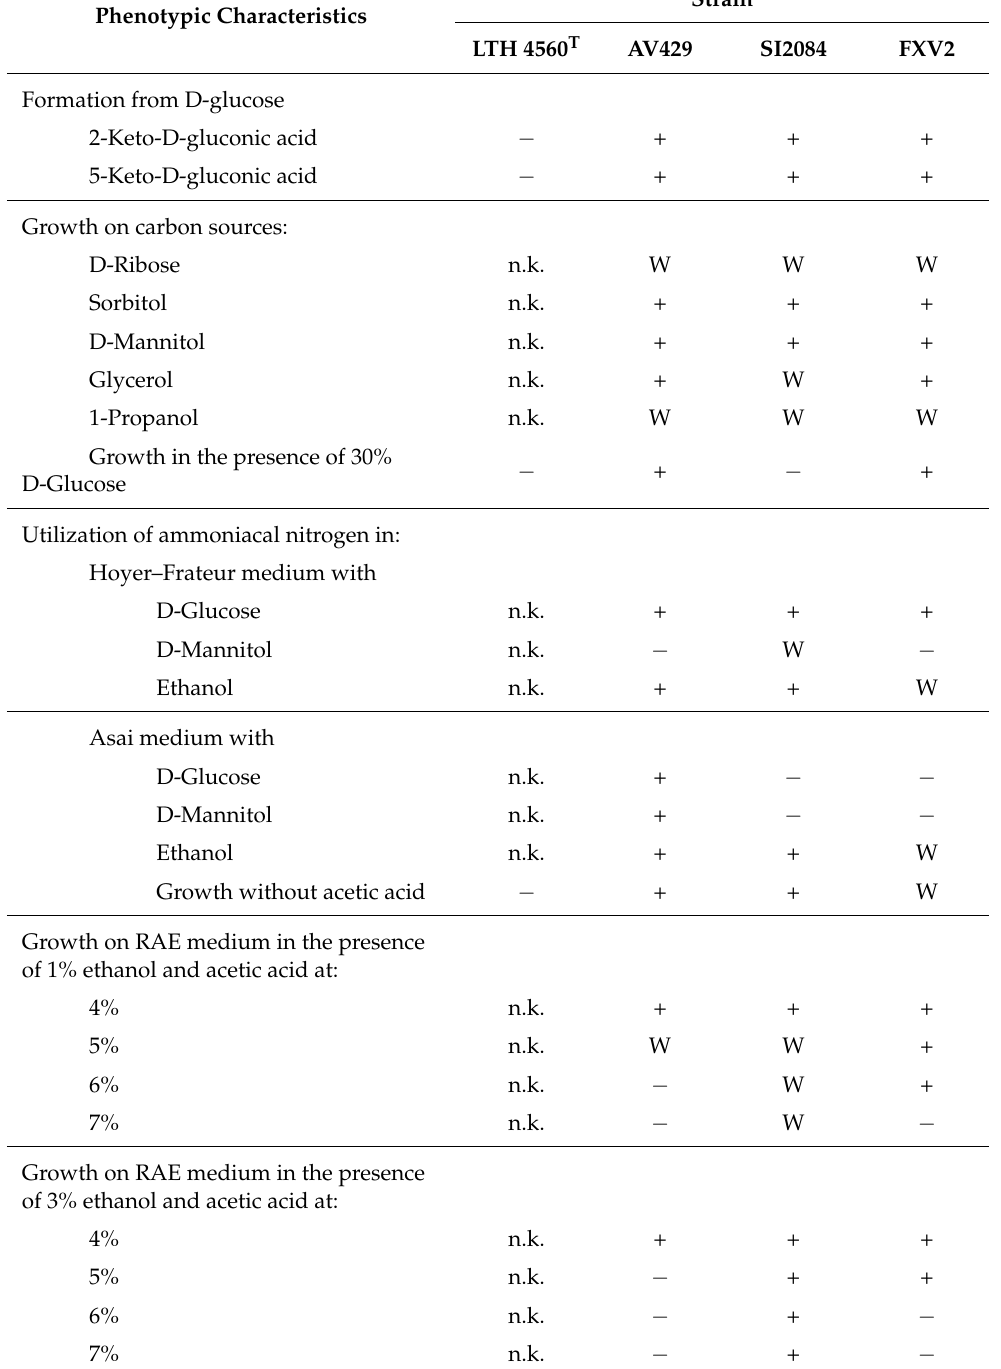
Table 4. Phenotypic characteristics of Gluconacetobacter entanii strains. Phenotypic Characteristics